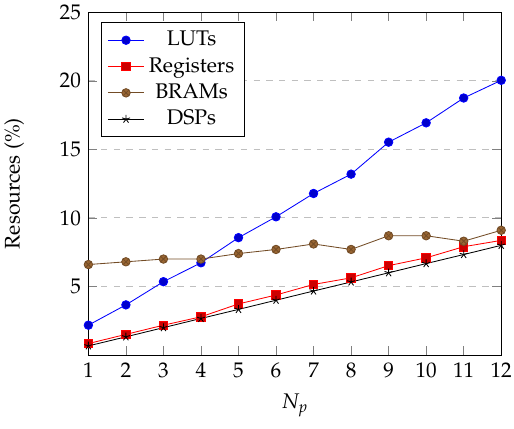
Figure 16. Resource use on Zynq